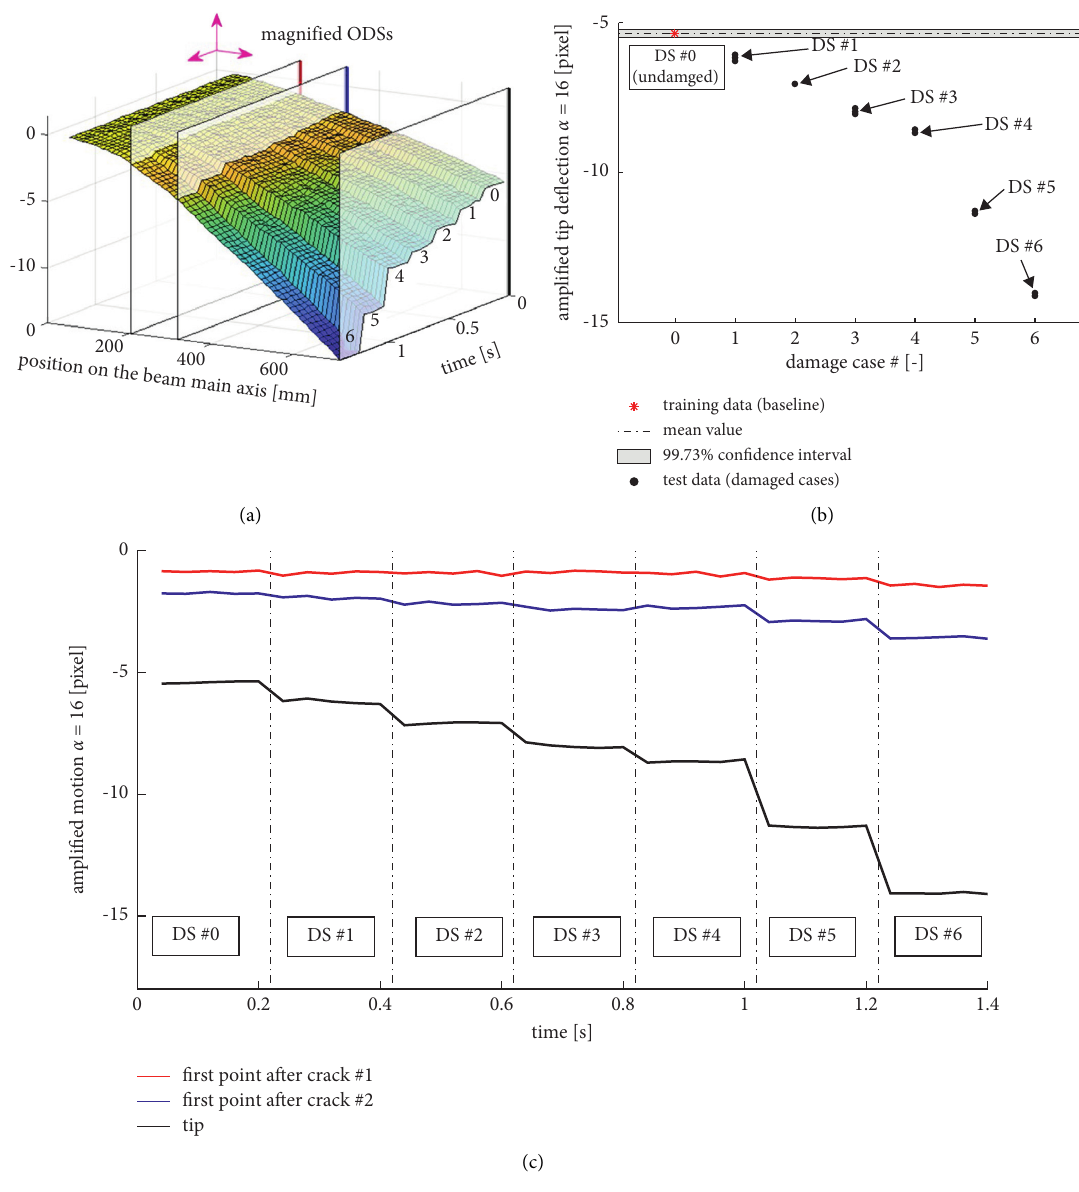
Figure 7: (a) The concatenated minima of the magnified ODSs corresponding to the first natural frequency, ordered for increasing damage severity (0: undamaged; 1–6: damaged as described in Figure 4). (b) ODS-based damage detection, comparing the tip deflection of the damaged scenarios to the pristine baseline. (c) The different displacements at three cross sections: x � 215 (red), x � 325 (blue), and x � L � 716mm (black) (cantilevered box beam, five periods per damage case, α �